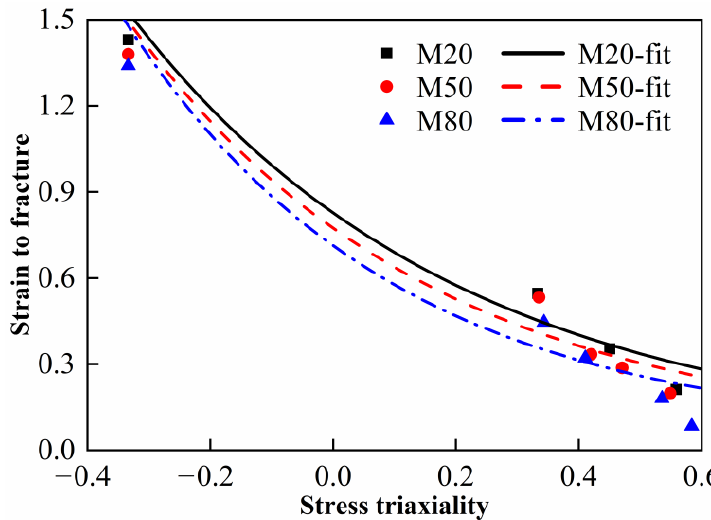
Figure 9. Stress triaxiality varies with equivalent strain for ( a ) M20, ( b ) M50 and ( c ) M80.